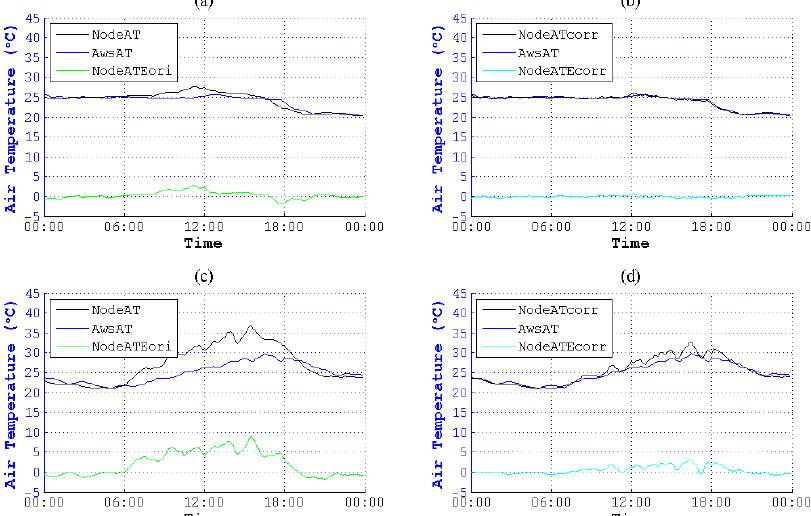
Figure 12. Contrast of NodeAT and NodeATcorr on 4 July 2014 and 7 July